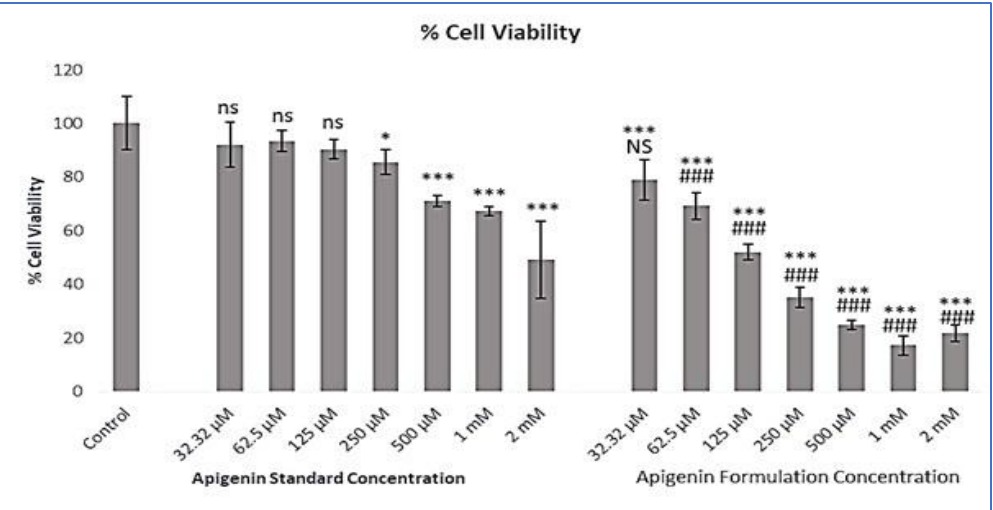
Figure 7. Effect of different concentrations of apigenin standard and apigenin formulation (optimized APG-PEGylated CNPs) on cell viability of A549 cells evaluated by MTT assay. Results are expressed as percentage mean ± SD ( n = 3) (ns = not significant when compared with control; * = p < 0.05 when compared with control; *** = p < 0.001 when compared with control; NS = not significant when compared with same concentration group of apigenin standard; ### = p < 0.001 when compared with the same concentration groups of apigenin